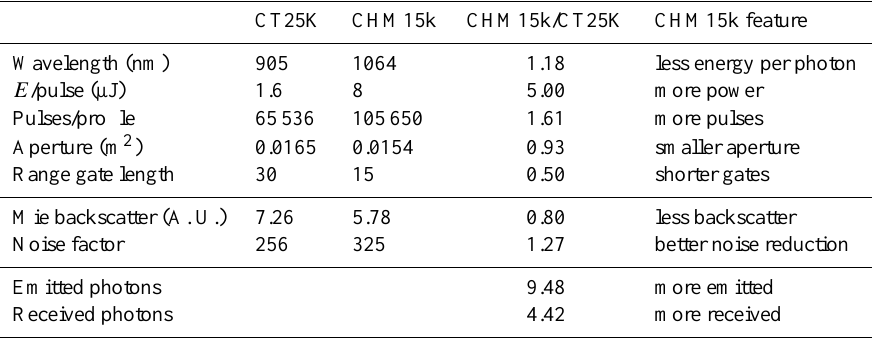
Table 1. Comparison of the performance of the Vaisala CT25K and Jenoptik CHM15k ceilometers. E is energy, noise factor is the square root of the number of pulses per profile, i.e. a measure for the increase in signal-to-noise ratio due to averaging over many pulses for one backscatter profile. The reduced backscatter is calculated from the wavelength using ν mie =1.4. CT25K